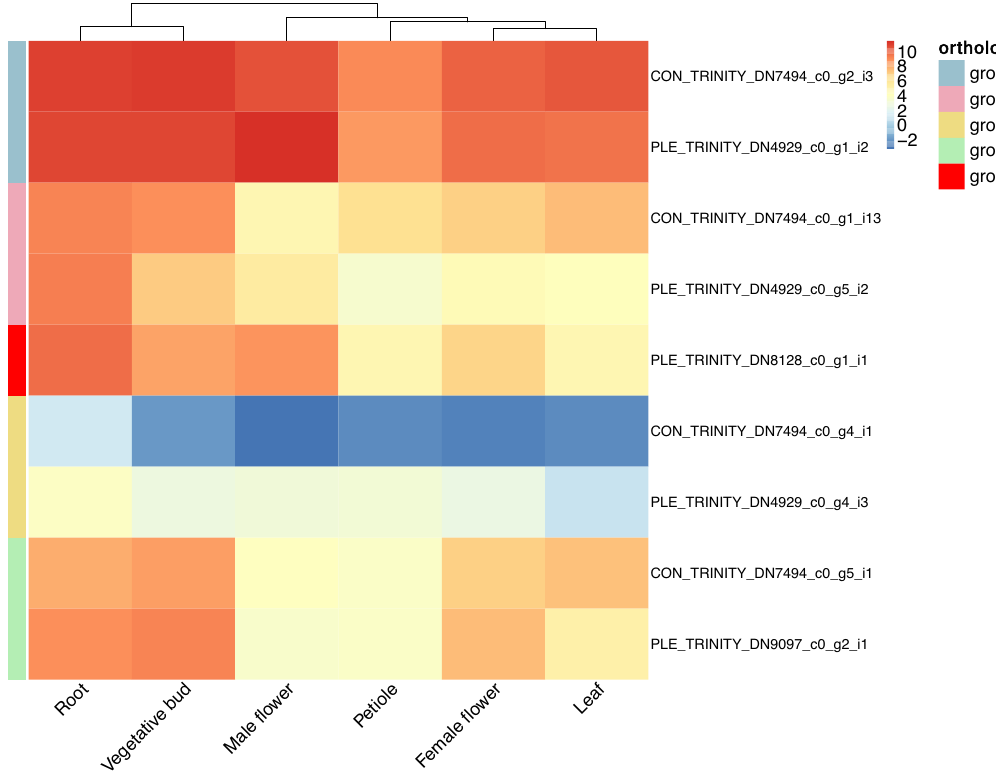
Figure 5. Heatmap of log2 FPKM of CHS homologs in B. conchifolia and B. plebeja. Ortholog groups refer to highlighted homologous CHS pairs in the ML gene